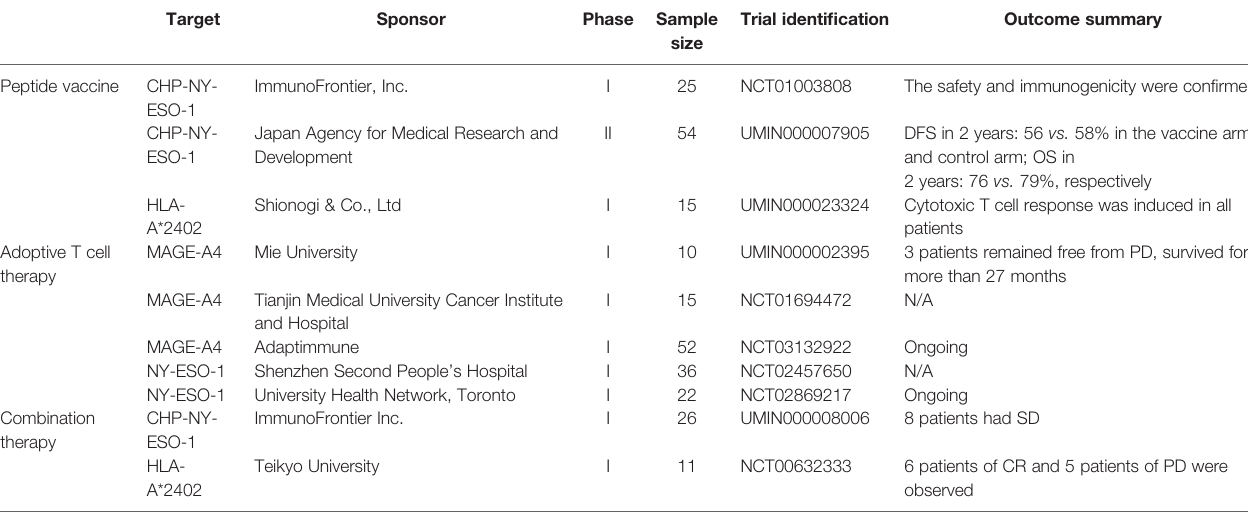
TABLE 1 | List of trials with neoantigens for EC or solid tumors including EC. Target Sponsor Phase Sample